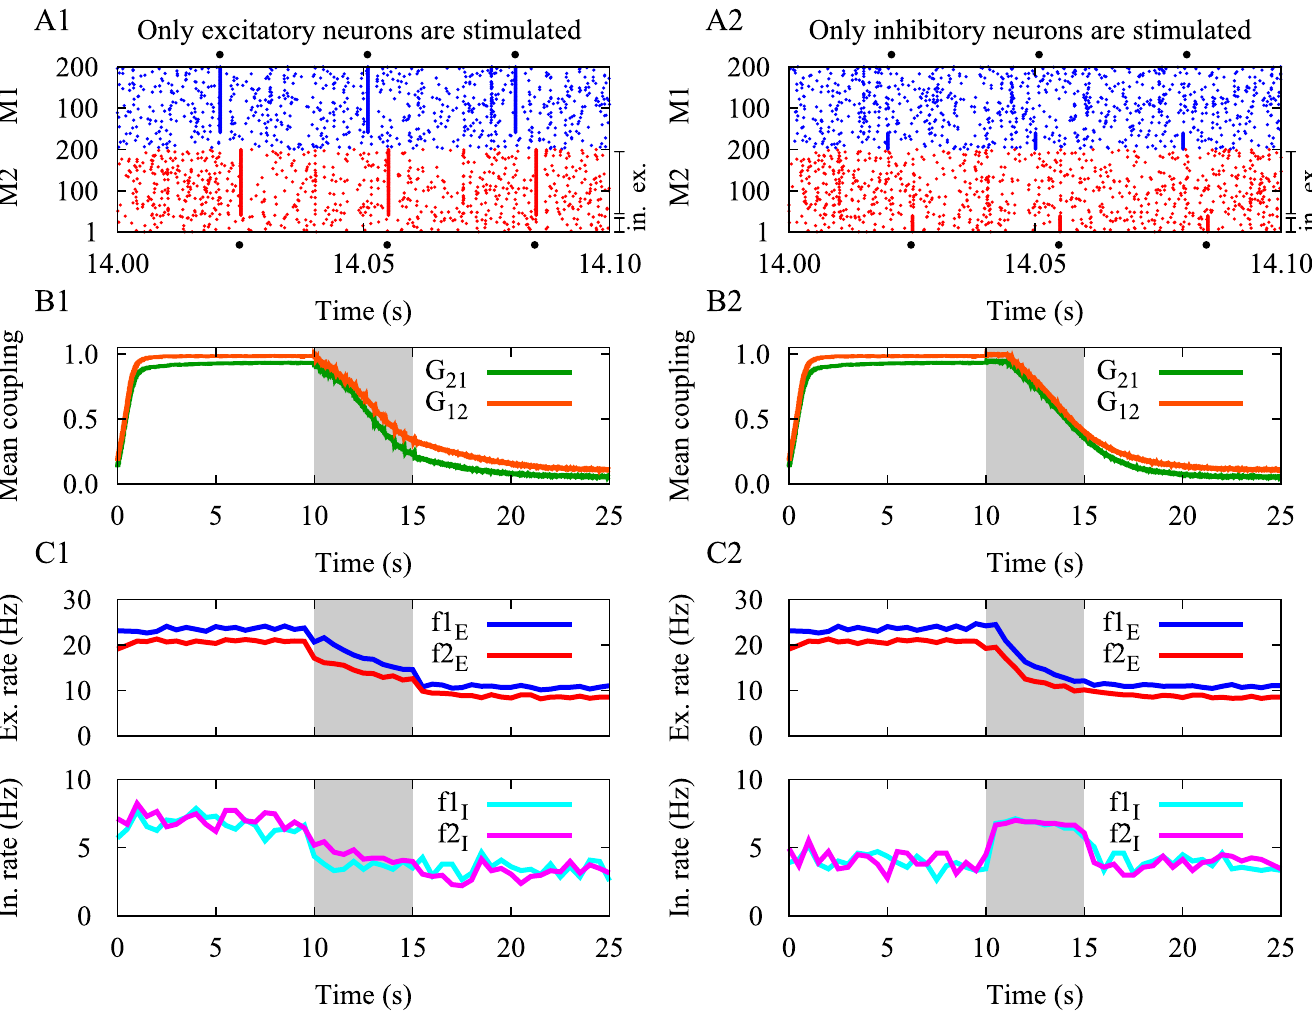
Fig 7. Targeting excitatory cells or inhibitory cells during stimulation. Stimulation outcome when only excitatory neurons (left column) and only inhibitory neurons (right column) were stimulated. ( A1,A2 ) Raster plots are shown for the modules during a 100 ms window of the 5 s stimulation epoch. In each module, neurons #1 to #40 are inhibitory and the remaining are excitatory. For clarity, the onset times of stimulation are indicated with black circles around each panel. ( B1, B2 ) Time course of the inter-population mean coupling. ( C1,C2 ) Time course of the mean firing rates of excitatory (top) and inhibitory (bottom) neurons in each module. Stimulation and STDP parameters were similar to those used in Fig 4 (see Tables 2 and